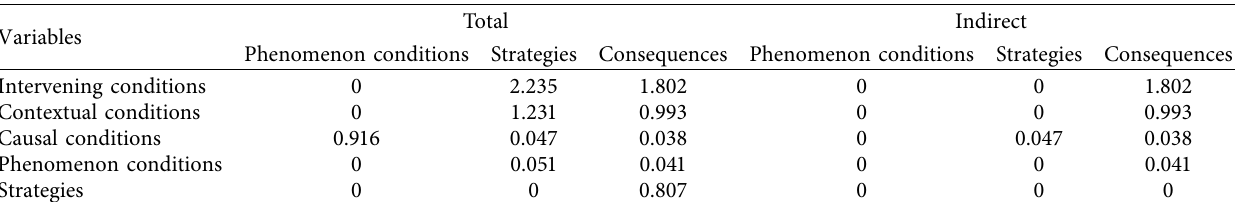
Table 9: Te results of ftting the model to check the indirect relationships of the